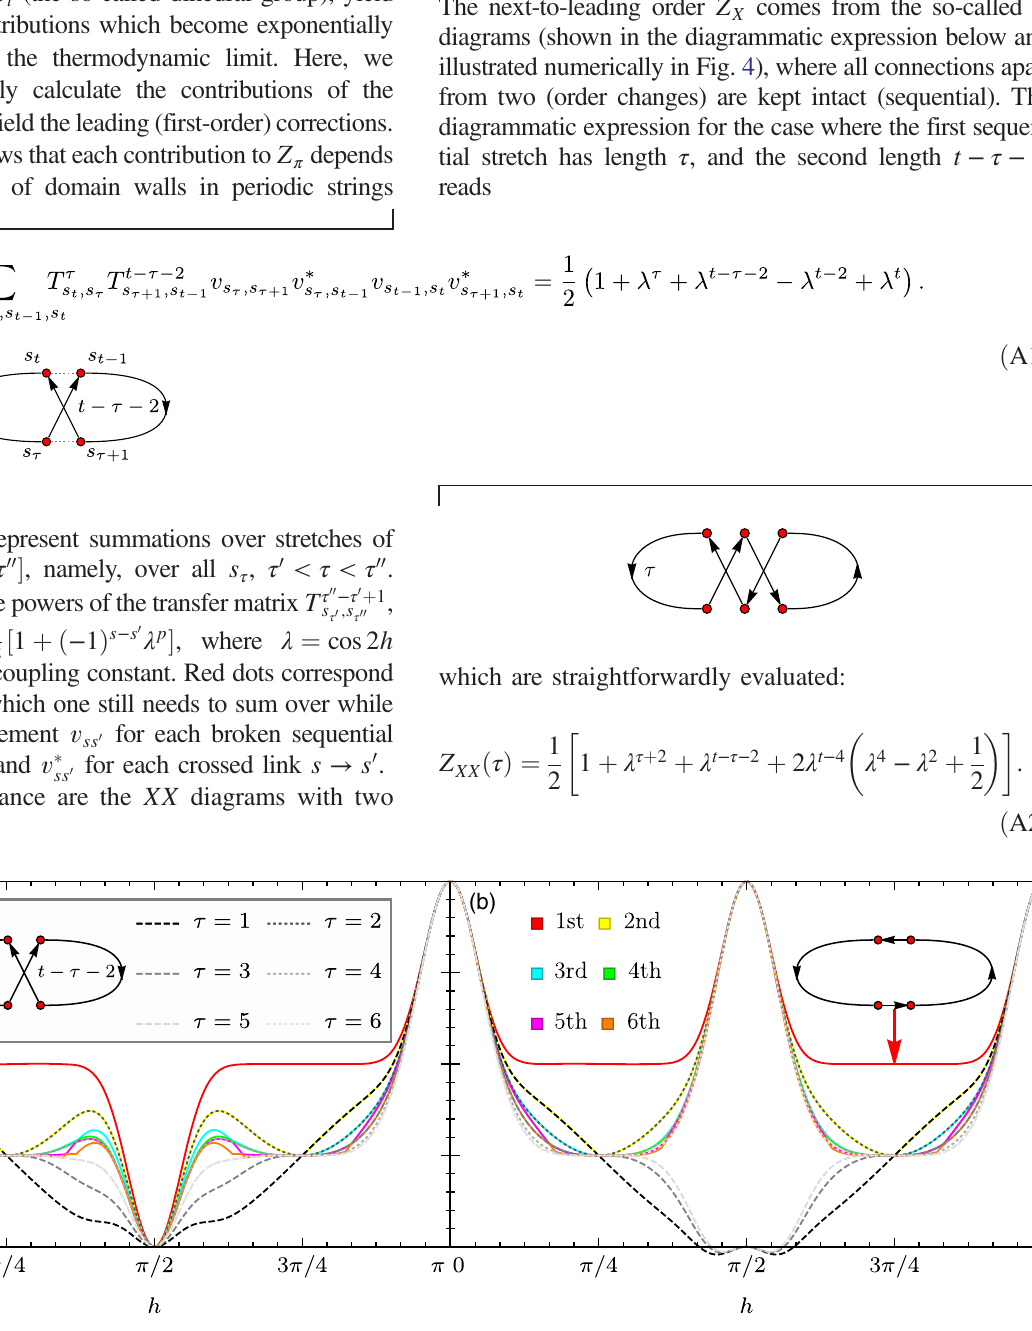
FIG. 4. Partition function Z π of the twisted one-dimensional Ising model for different permutation families is plotted against the field parameter h . Since in the expression the contribution occurs at a large power l , only the largest contribution matters in the first order (red), which corresponds to (anti)cyclic permutations. The first subleading corrections are given by the X diagrams for τ ¼ 1 , 2. The colored lines are numerical data for t ¼ 13 , 14 shown in (a) and (b), respectively. Dashed lines are the exact expressions for Z X ð τ Þ given by Eq. (A1). Note that all terms have multiplicities which are multiples of 2 t